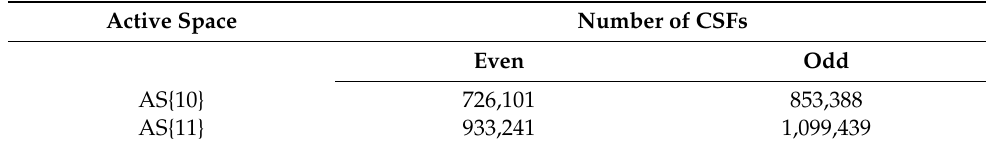
Table 2. The number of CSFs generated for each AS considering the CC correlations for Xe 43 + . Active Space Number of CSFs Even Odd AS{10} 726,101